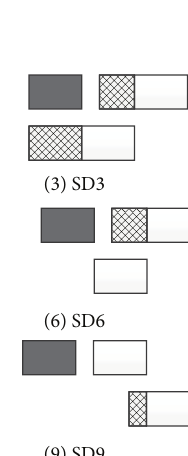
Figure 7: Timetable for two bays.